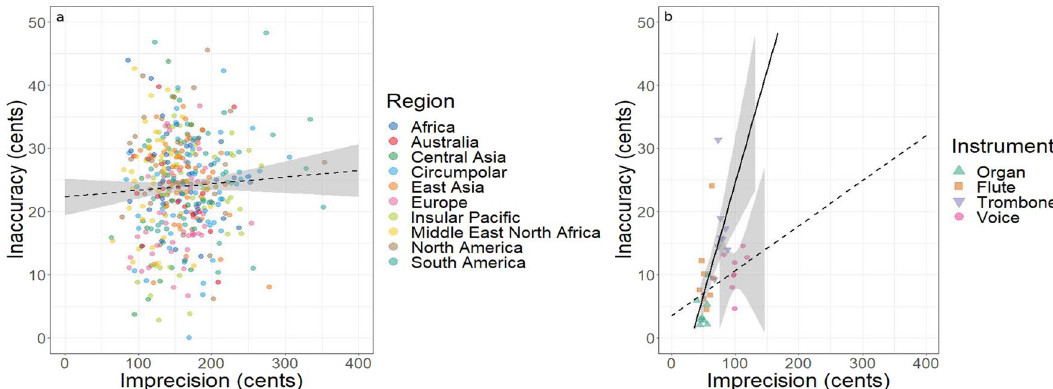
Figure 5. The relationship between imprecision and inaccuracy in each of the two studies. ( a ) Global vocal pitch production across regions in Study 1, taking the mean pitch-class inaccuracy for each song relative to the same song’s mean pitch-class imprecision. The dashed line indicates the linear regression (F = 1.435, df = 415, p > 0.2; adjusted R 2 = 0.001) of vocal imprecision and inaccuracy across all regions, with the shaded grey region indicating the standard error. ( b ) Pitch production profiles across instruments in Study 2, taking the average pitch-class inaccuracy for each song relative to the same song’s average pitch-class imprecision. The dashed line indicates the linear regression for the voice alone (F = 0.392, df = 6, p > 0.5, adjusted R 2 = 0.095), while the solid line indicates the linear regression for the three non-vocal instruments combined, with the shaded grey region indicating the standard error (F = 18.41, df = 22, p < 0.001, adjusted R 2 =